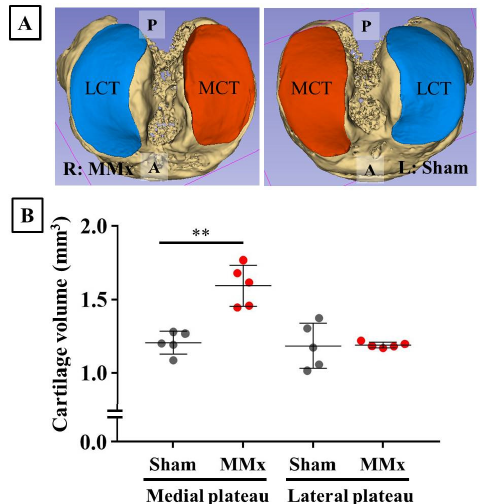
Figure 6. Reconstruction and volume calculation of the articular cartilage and subchondral bone using the CEX- µ CT imaging method. ( A ) A representative case of reconstructed articular cartilage and subchondral bone. ( B ) Comparison of cartilage volumes between MMx-treated and sham-treated knees. The medial cartilage volumes were significantly increased in the MMx-treated knee compared with that in the sham-treated knee. Abbreviations: P, posterior; A, anterior; MCT, medial cartilage of the tibial plateau; LCT, lateral cartilage of the tibia plateau. ** p < 0.01 on paired t -test.